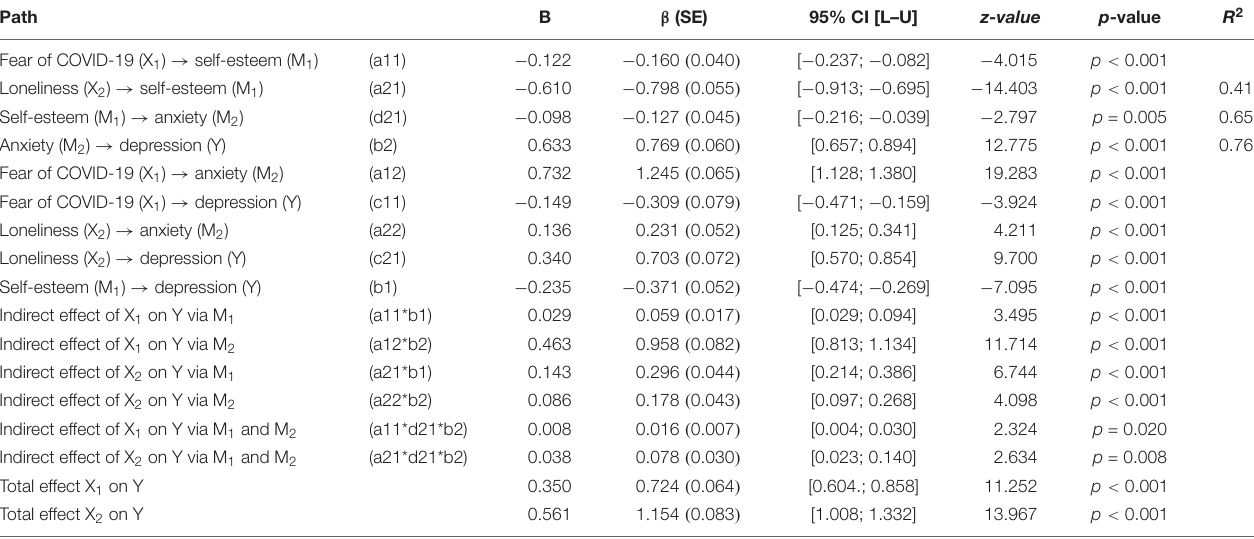
TABLE 4 | Summary of parameter estimates (beta) with 95% confidence intervals for key pathways tested full model, Model 4 – Figure 2 . Path B β